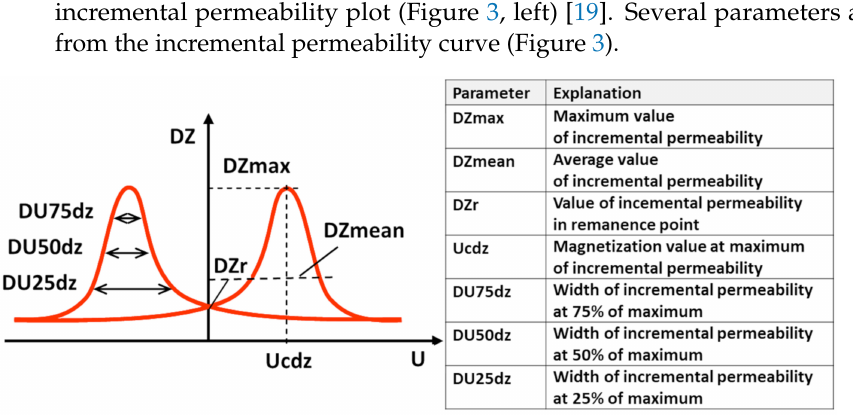
Figure 3. Schematic illustration of the incremental permeability curve and the parameters